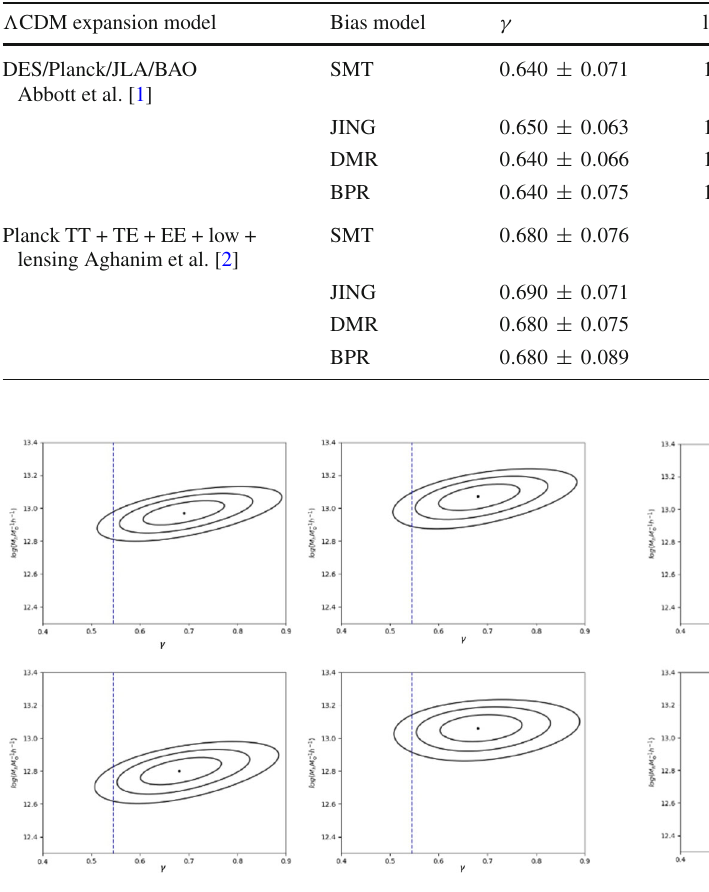
Fig. 2 The iso-likelihood contours for 1 σ —2 σ -3 σ levels in the (γ, M ) parameter space for different bias models. Upper row: From h lefttoright,JINGandSMTmodels.Lowerrow:DMRandBPRmodels. For further details regarding the models, please see the relevant section. Notice that we use the Planck TT+TE+EE+low+lensing (cid:7) CDM cos- mology [2]. The best fit values are given in Table 2. The vertical dashed line corresponds to γ GR ≈ 6 /